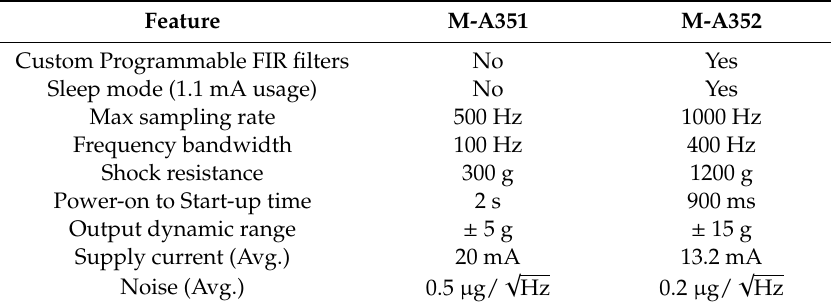
Table 2. Comparison between M-A352 and M-A351 accelerometers